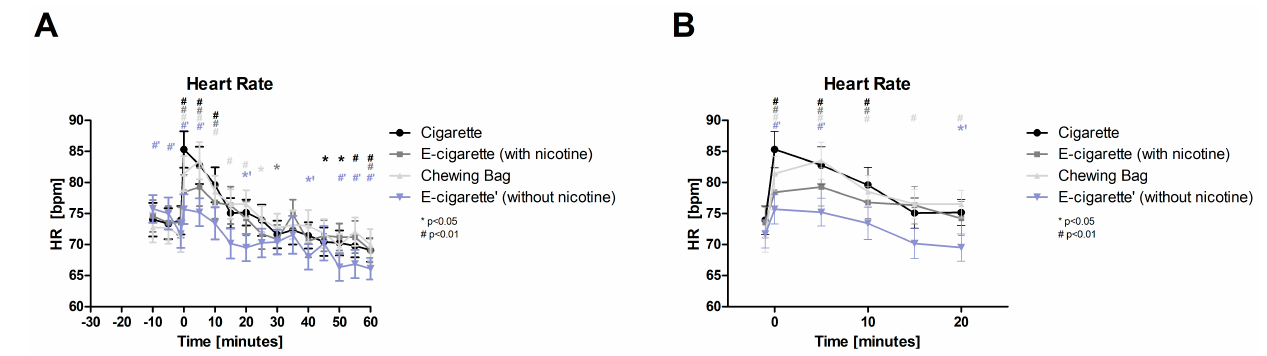
Figure 5. Central diastolic blood pressure ( A ) total follow-up; ( B ) follow-up of expected nicotine half-life. The cDBP plotted against time shows a highly significant (# p < 0.01) immediate increase (time 0) in Cig and Chewing bag. All four test groups, normally distributed, display a highly significant (# p < 0.01) increase at 5 min and 10 min after the intervention (E-Cig (-) significant with * p < 0.05). E-Cig (+) stays significantly elevated over a long period.